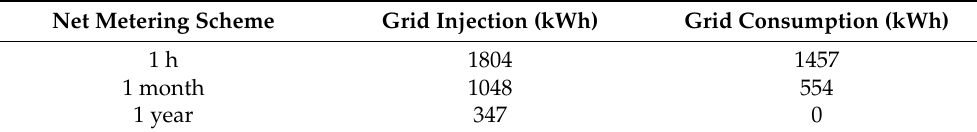
Table 9. Energy injection to grid and energy consumption from grid for different net metering